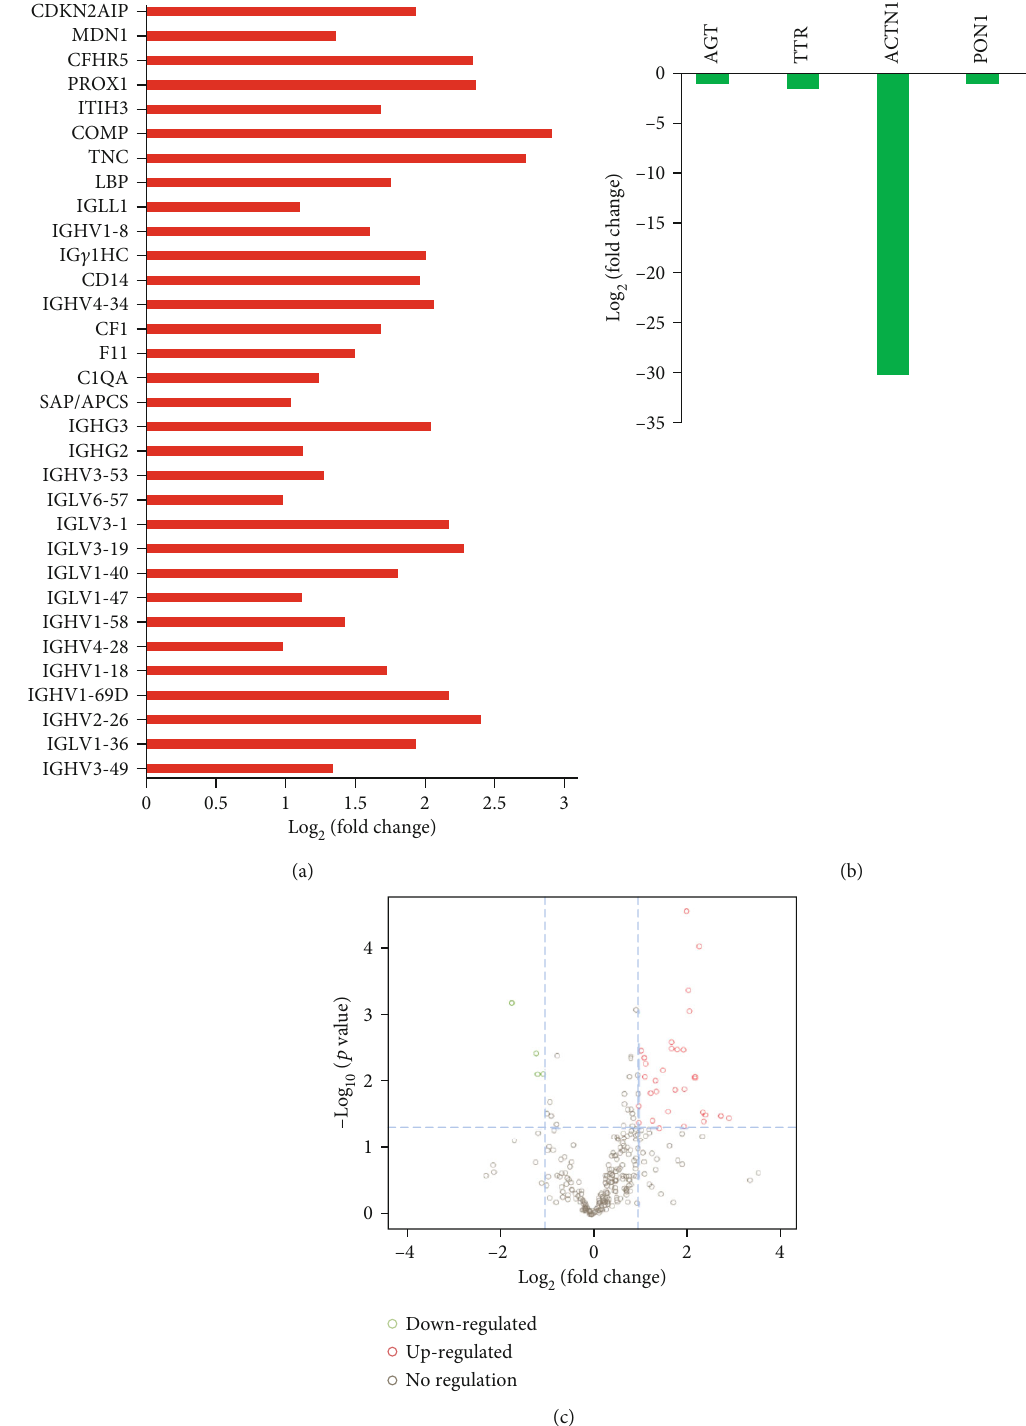
Figure 1: The exosomal protein pro fi les in rheumatoid arthritis patients. (a) The upregulated di ff erentially expressed proteins. Details for abbreviated protein names are shown in Tables 2 and 3. (b) The downregulated di ff erentially expressed proteins. (c) Volcano plots of di ff erentially expressed proteins based on protein abundance changes and t -test (red circle: upregulated proteins; green circle: downregulated proteins; grey circle: no di ff